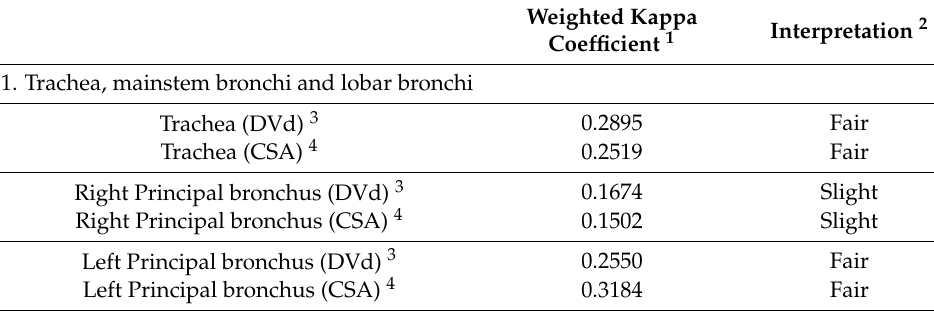
Table 8. Weighted kappa coefficients scores and interpretation of magnitude of agreement obtained from comparison of airway collapse between inspiratory/expiratory breath-hold CT and tracheo- bronchoscopy in dogs with spontaneous respiratory disease based upon CT-derived airway diameter (DVd) and cross-sectional area (CSA) for trachea, mainstem bronchi and lobar bronchi and for bronchomalacia severity scoring systems for segmental and subsegmental bronchi. Weighted Kappa Interpretation Coefficient 1